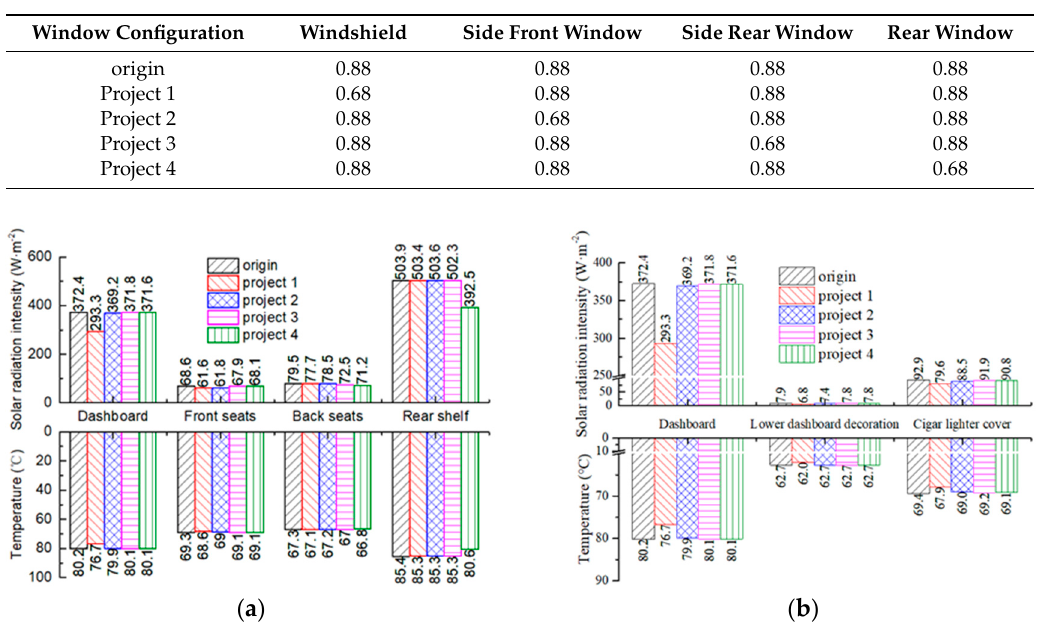
Figure 12. Influence of windows in different positions on the intensity and distribution of weathering external factors of different types of parts: ( a ) horizontal distribution of external factors; and ( b ) vertical distribution of external factors.